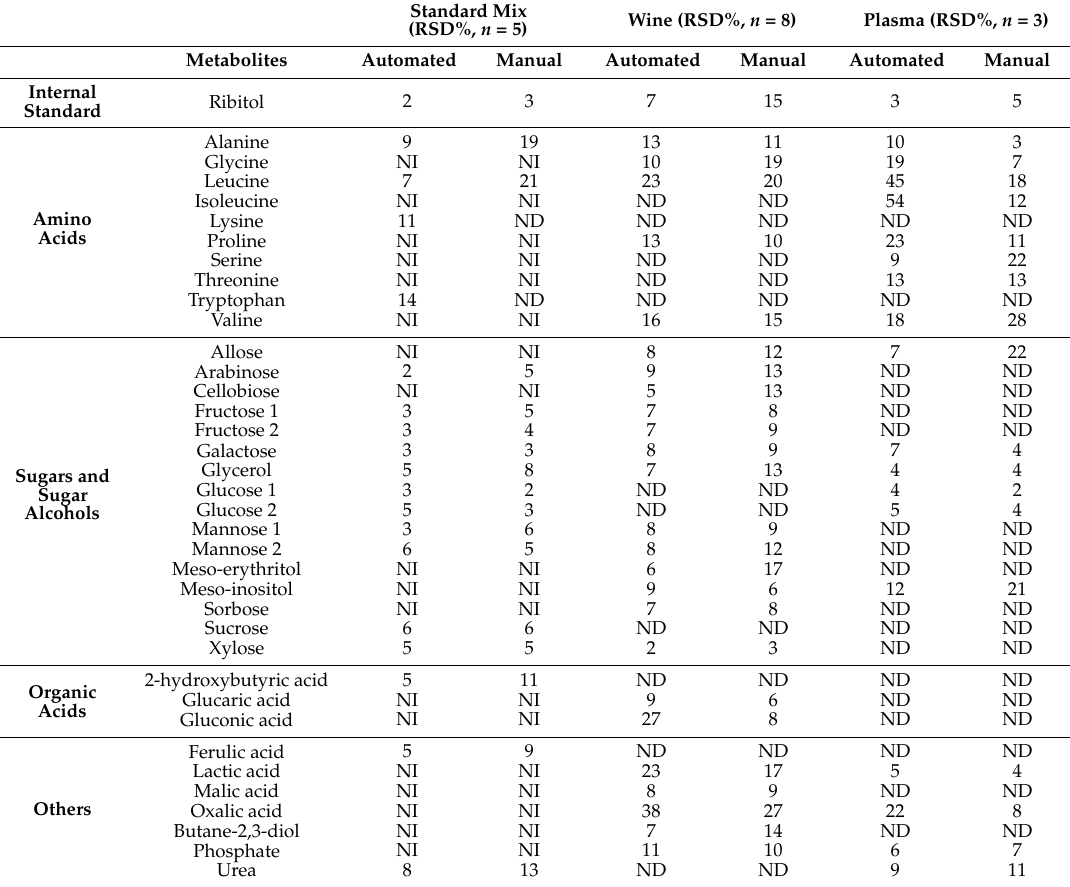
Table 2. Comparison between automatic (on-line) and manual (off-line) trimethylsilyl (TMS) derivatisation in different